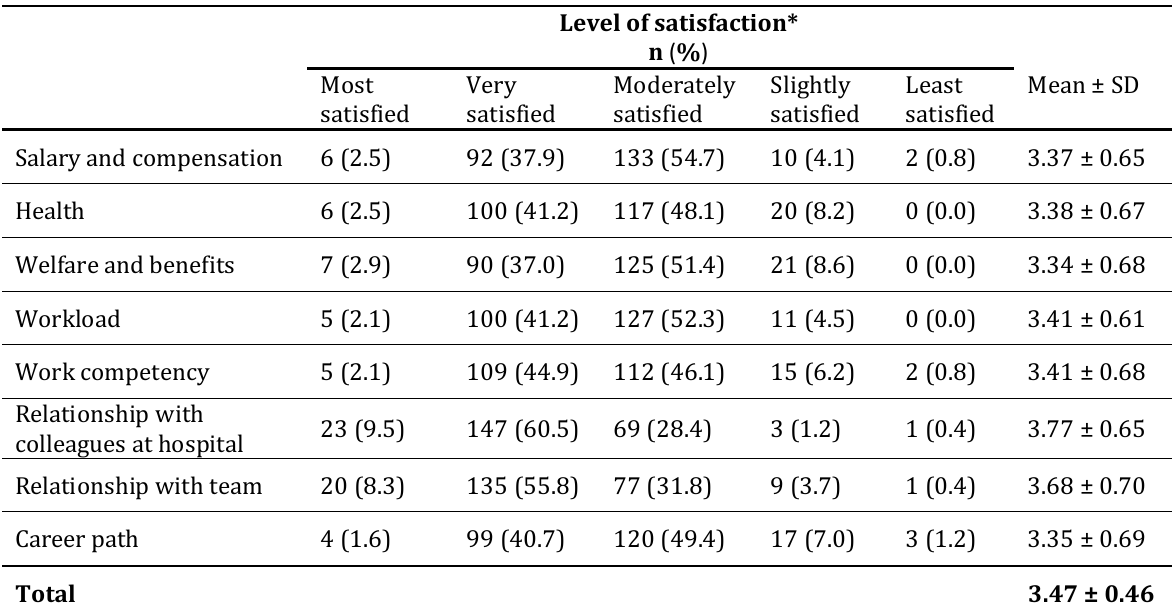
Table 3: Pharmacists’ job satisfaction with AMR